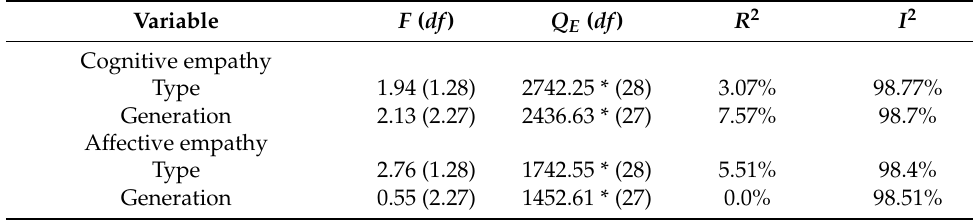
Table 4. Results of the ANOVA for moderators.